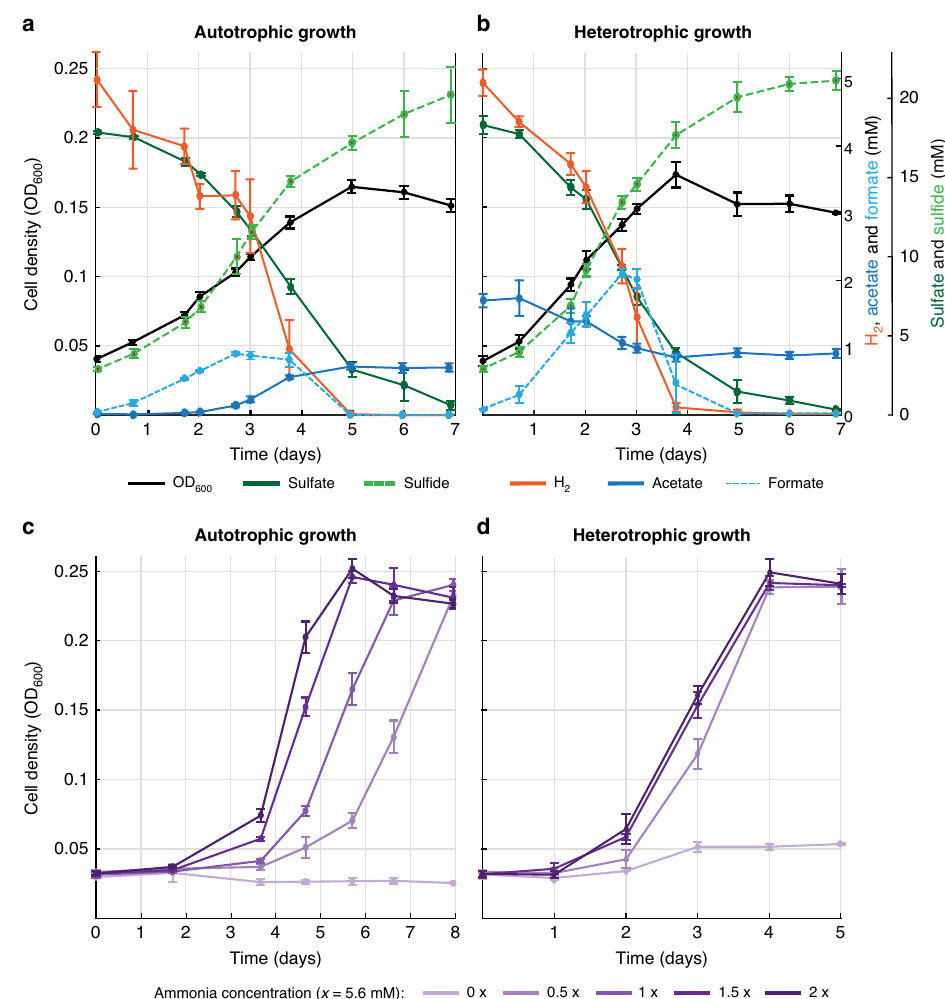
Fig. 1 Comparison of growth of D. desulfuricans under autotrophic and heterotrophic conditions. Autotrophic growth (H 2 /CO 2 /sulphate) after some adaptation transfers ( a ) is similar to heterotrophic growth (acetate/H 2 /CO 2 /sulphate ( b ). Increasing ammonium concentrations do have an effect on the autotrophic growth ( c ), but not on heterotrophic growth ( d ). All growth experiments were performed at 30 °C and 175 rpm in triplicates in 250 ml glass bottles containing 100 ml anoxic minimal medium. Error bars represent the standard deviation. Source data are provided with this paper, and raw data can be found in Supplementary Data